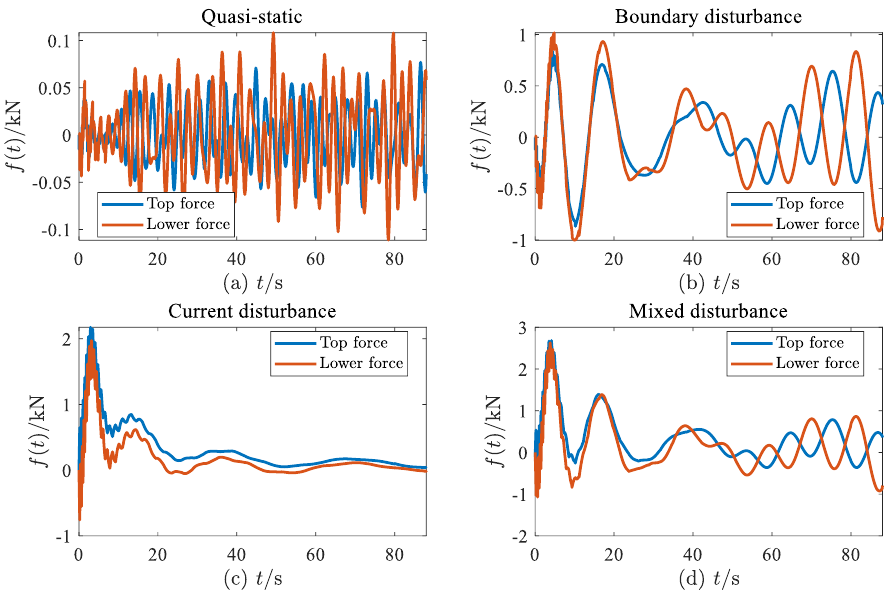
Figure 6. Reacting force from the umbilical cable: ( a ) Quasi-static; ( b ) Boundary disturbance; ( c ) Cur- rent disturbance and ( d ) Mixed disturbance.